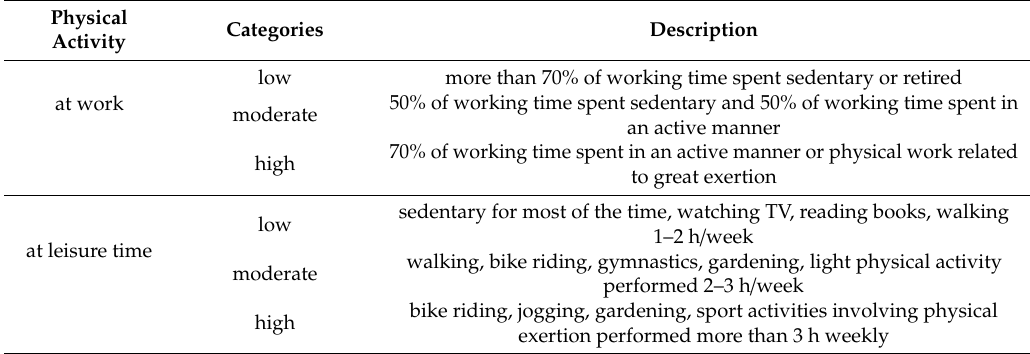
Table 5. Description of the categories of physical activity at work and at leisure time [45].